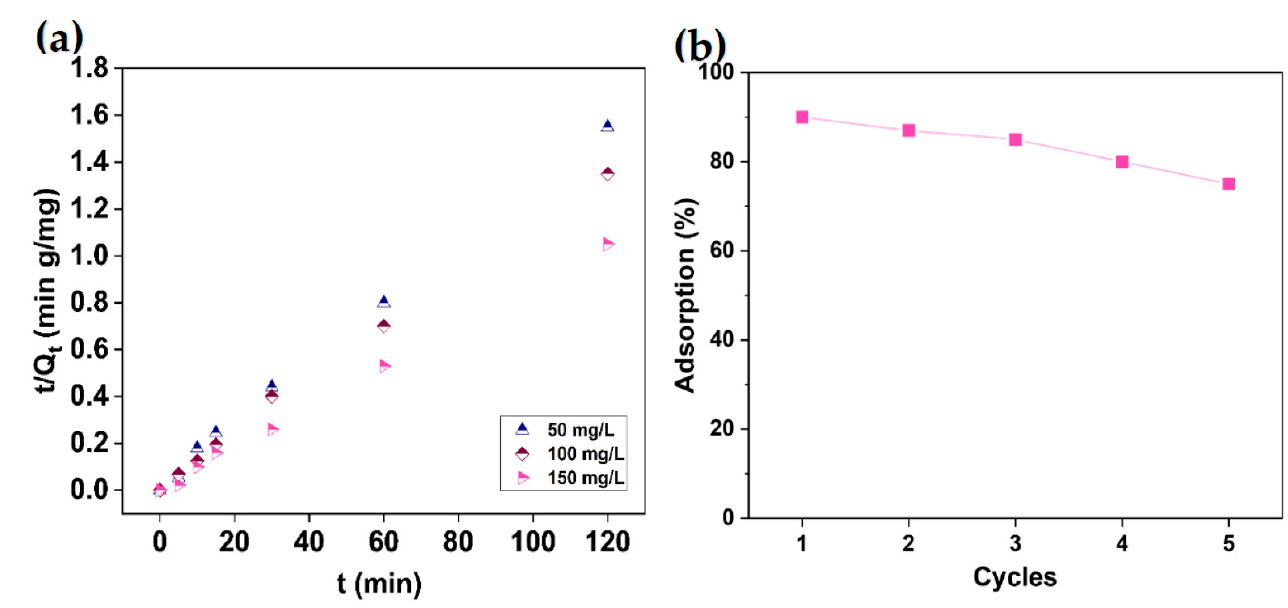
Figure 7. ( a ) Adsorption kinetics of the MSH@MA NPs in an aqueous solution of Cu 2+ ions at an initial concentration of 50, 100, and 150 mg/L, respectively. ( b ) Adsorption–desorption efficiency towards Cu 2+ ions in different cycles by MSH@MA NPs. Table 1. The pseudo-second-order rate constant of adsorption kinetics of MSH@MA NPs in an aqueous solution of Cu 2+ ions.